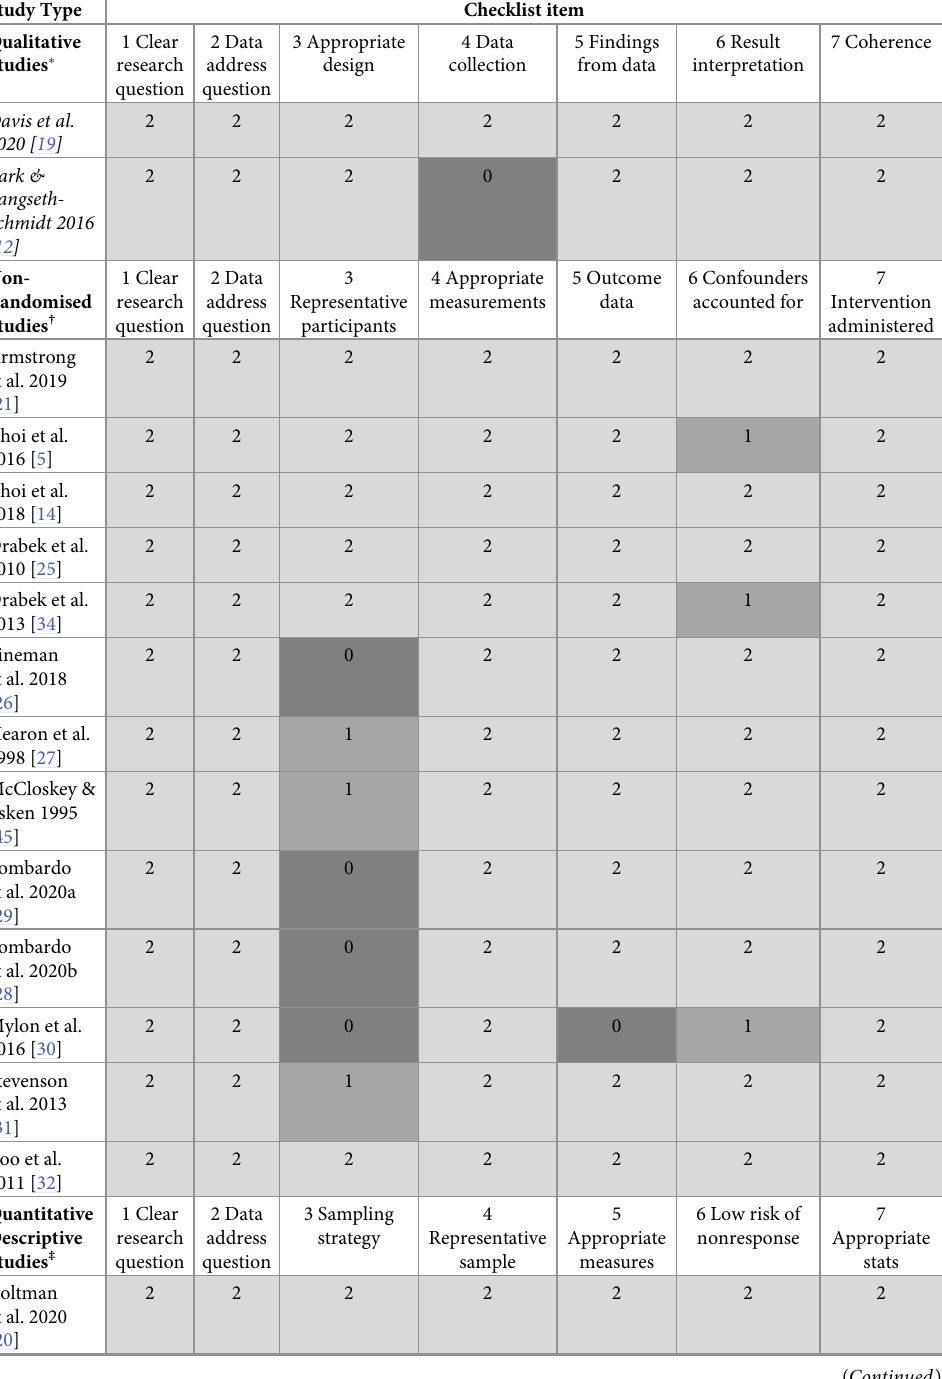
Table 3. Quality assessment of the included 16 studies, based on the Mixed Methods Appraisal Tool criteria (MMAT) [44]. A score of 0 indicates a high risk of bias (dark grey), a score of 1 indicates an unclear risk of bias (grey) and a score of 2 indicates a low risk of bias (light grey); a description of the 7 checklist items is presented for each type of study in the figure legend. NB: Studies labelled in italics are Mixed-Methods (Davis et al. 2020; Park & Langseth- Schmidt et al. 2016); as per the MMAT [44], these studies were assessed on both Qualitative and Quantitative /Non- Randomised study criteria